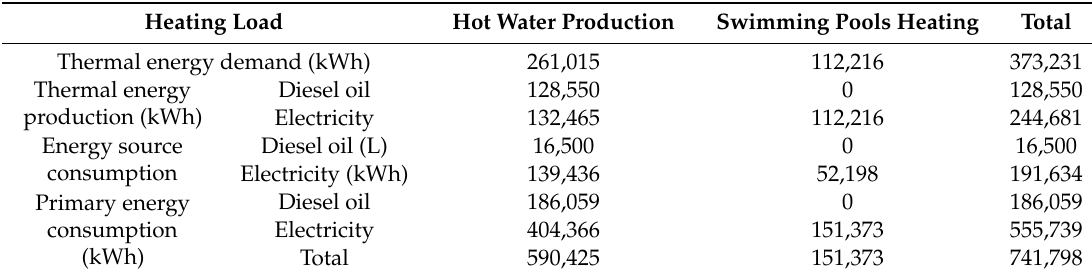
Table 3. Annual thermal and primary energy consumption for the production of hot water and the swimming pools heating in the existing operation of the Pancretan Stadium.